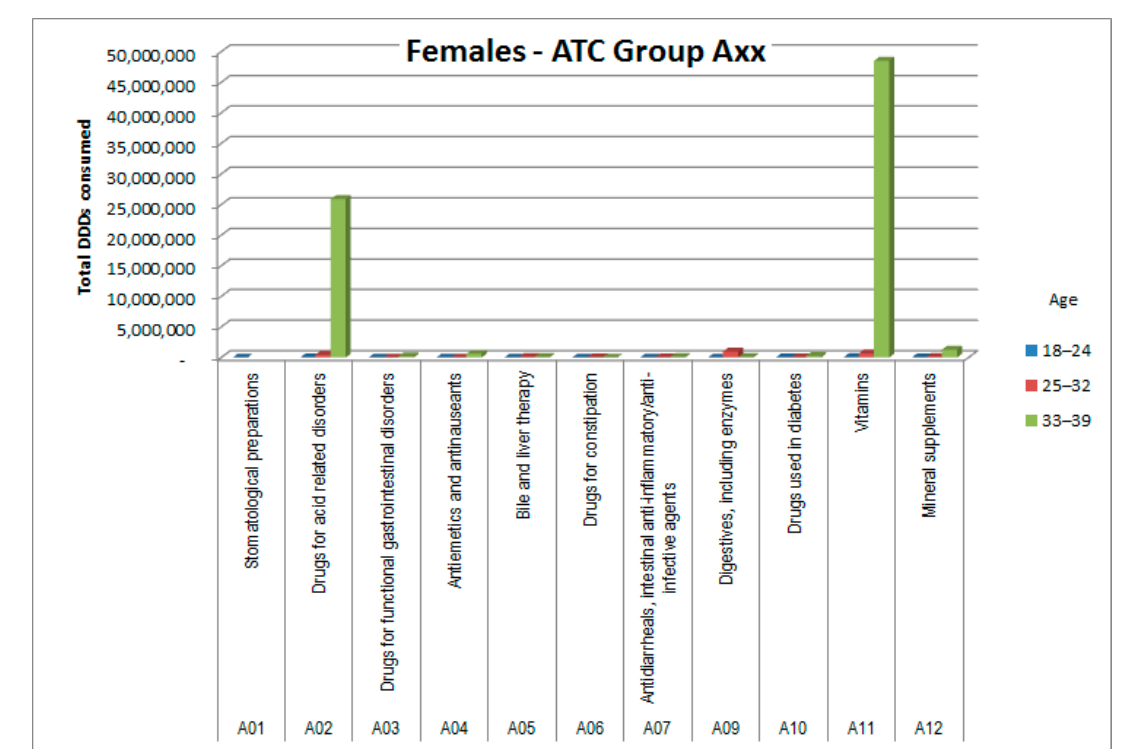
Figure 6. DDD consumption for females, ATC group Cxx.